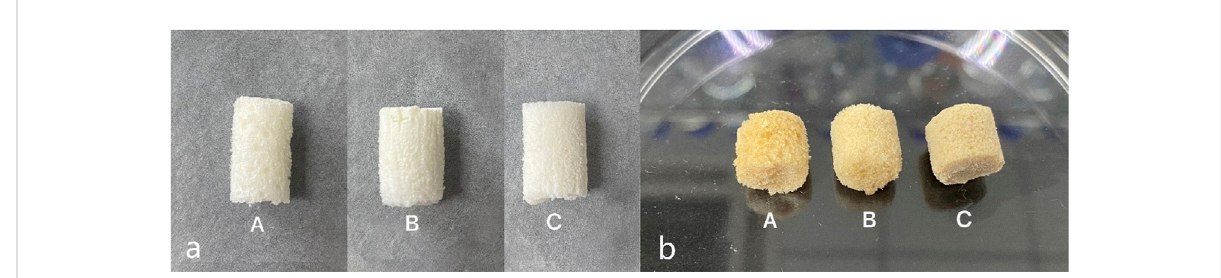
FIGURE 1 Macro appearance of the scaffold (a) before and (b) after crosslinking with glutaraldehyde. Images from the left to right are group A (10% HCP), group B (30% HCP), and group C (50% HCP). The scaffolds were white to pale yellow and translucent with a porous morphology even after crosslinking with